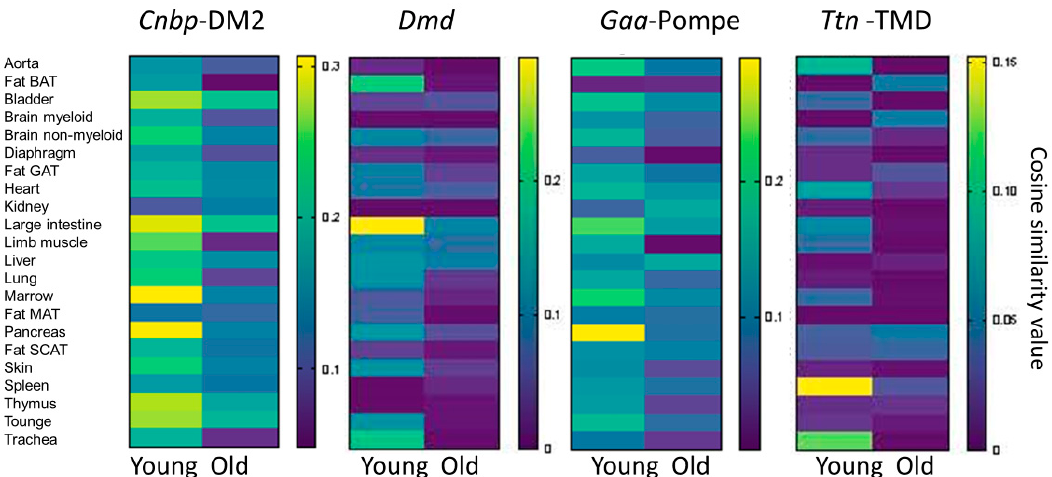
Figure 3. Correlation of Adnp and muscle disease genes in the single-cell / general tissue. Heatmaps plotting cosine similarity values (indicating co-expression at the single-cell level) for the genes of interest (indicated above each heatmap) and Adnp in young (3 months) and aged mice (18 and 24 months) in 22 tissues (indicated in rows). GAT, SCAT, MAT, and BAT stand for gonadal-, subcutaneous-, mesenteric- and brown-adipose tissue.